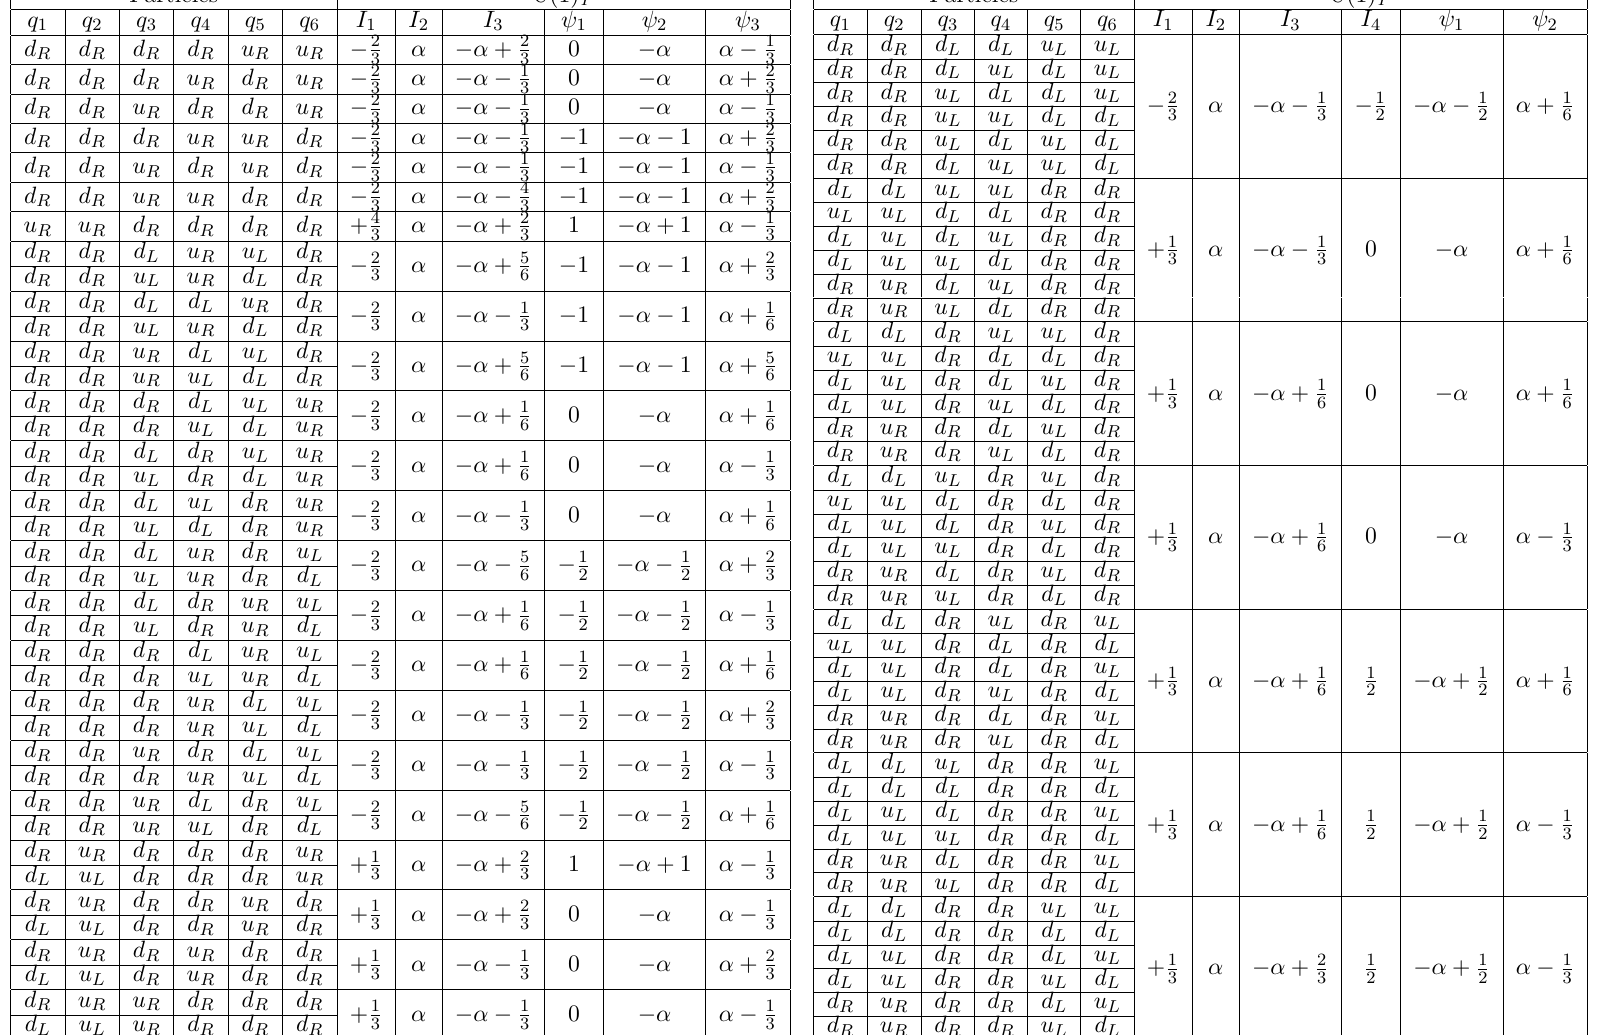
Table 8 . The possible U(1) Y numbers of the fields in